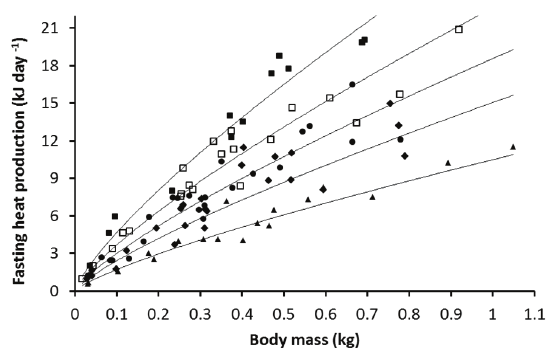
of pacu as function of f